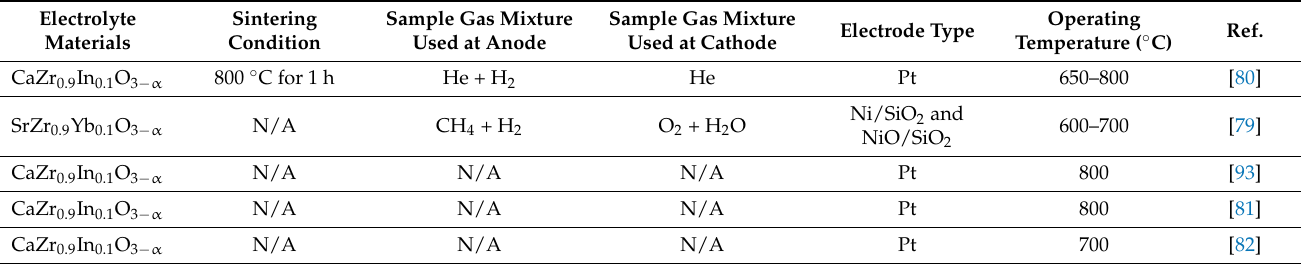
Table 2. Zirconate-based tritium recovery